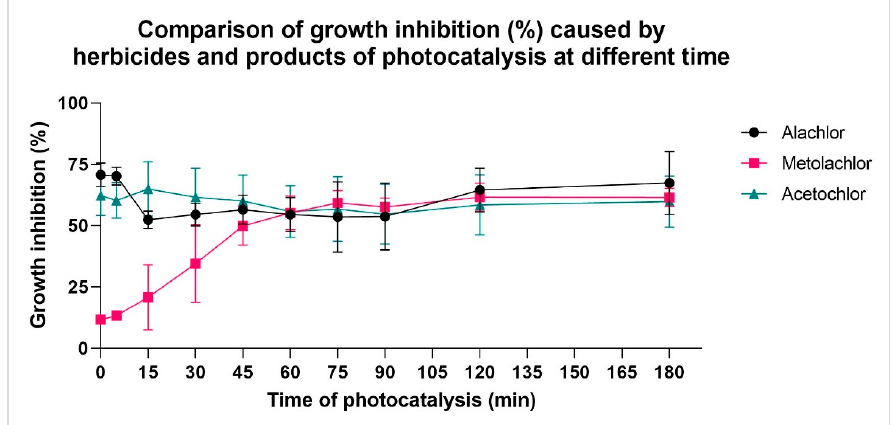
Figure 4. The average growth inhibition (%) of Chlorella kessleri exposed to a mixture of herbicides and their photocatalytic degradation products collected at a different time of photocatalysis.